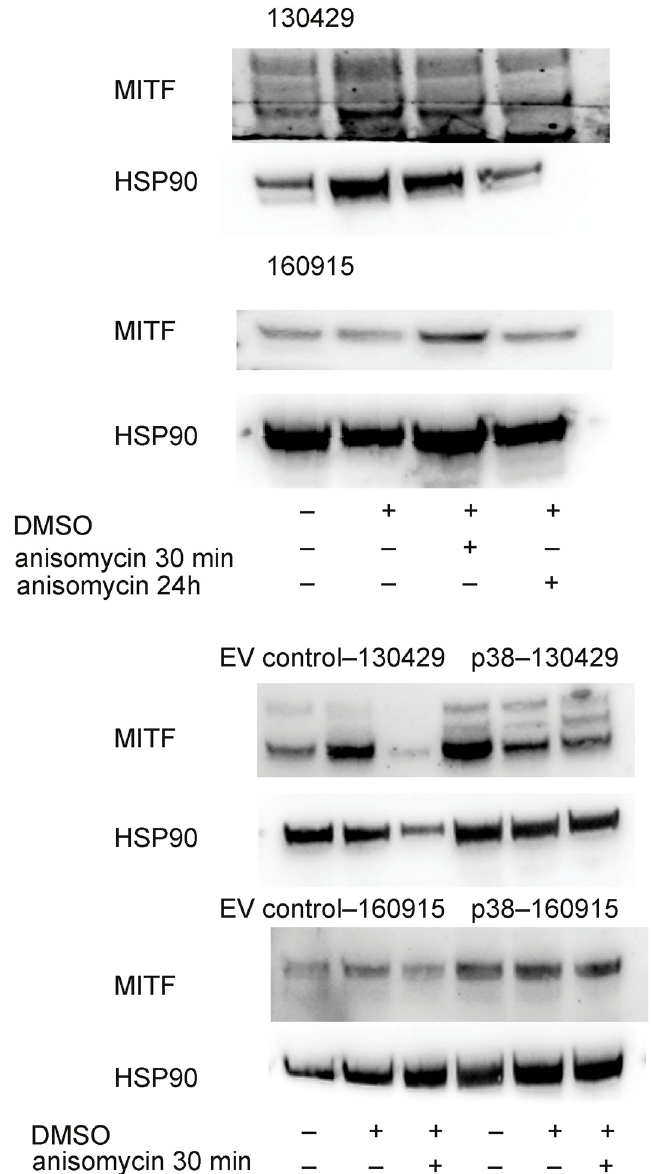
Figure 3. First and second panel: Protein expression of MITF with HSP90 as loading control under the untreated, DMSO, 0.1 µ M anisomycin for 30 min, and 0.1 µ M anisomycin for 24 h treatment conditions in cell lines 134029 and 160915. Third and fourth panel: Protein expression of MITF with HSP90 as loading control under the untreated, DMSO, and 0.1 µ M anisomycin for 30 min treatment